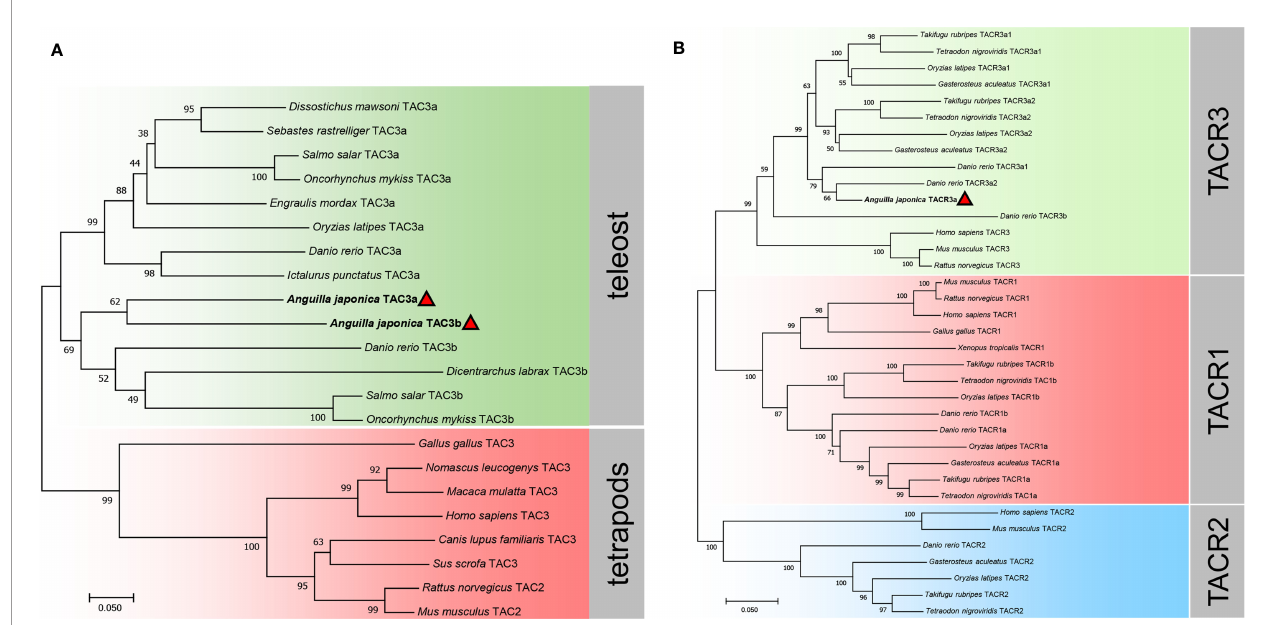
FIGURE 3 | Phylogenetic analysis of the tac3 (A) and tacr (B) gene family in vertebrates. The phylogenetic trees were constructed by MEGA 7 using the neighbor-joining method. Data were resampled with 1,000 bootstrap replicates. The accession numbers of each sequence are Dissostichus mawsoni tac3a (DAA35156.1), Sebastes rastrelliger tac3a (XP_037630002.1), Salmo salar tac3a (XP_013991334.1), Oncorhynchus mykiss tac3a (XP_021421533.1), Engraulis mordax tac3a (DAA35163.1), Oryzias latipes tac3a (NP_001265832.1), Danio rerio tac3a (NP_001243318.1), Ictalurus punctatus tac3a (XP_017343311.1), Danio rerio tac3b (NP_001243319.1), Dicentrarchus labrax tac3b (QYB17058.1), Salmo salar tac3b (XP_014022643.1), Oncorhynchus mykiss tac3b (CDQ91399.1), Gallus gallus tac3 (XP_015155892.2), Nomascus leucogenys tac3 (XP_003252831.1), Macaca mulatta tac3 (XP_001115535.2), Homo sapiens tac3 (AAQ10783.1), Canis lupus familiaris tac3 (NP_001279988.1), Sus scrofa tac3 (NP_001007197.1), Rattus norvegicus tac2 (NP_062035.1), Mus musculus tac2 (BAA03316.1), Takifugu rubripes tacr3a1 (NP_001267026.1), Tetraodon nigroviridis tacr3a1 (DAA35148.1), Oryzias latipes tacr3a1 (NP_001265839.1), Gasterosteus aculeatus tacr3a1 (XP_040043470.1), Takifugu rubripes tacr3a2 (NP_001267041.1), Tetraodon nigroviridis tacr3a2 (DAA35149.1), Oryzias latipes tacr3a2 (NP_001265803.1), Gasterosteus aculeatus tacr3a2 (XP_040042202.1), Danio rerio tacr3a1 (NP_001243567.1), Danio rerio tacr3a2 (NP_001243564.1), Danio rerio tacr3b (XP_002666594.1), Homo sapiens tacr3 (NP_001050.1), Mus musculus tacr3 (AAH66845.1), Rattus norvegicus tacr3 (NP_058749.1), Mus musculus tacr1 (NP_033339.2), Rattus norvegicus tacr1 (NP_036799.1), Homo sapiens tacr1 (NP_001049.1), Gallus gallus tacr1 (NP_990199.1), Xenopus tropicalis tacr1 (NP_001106489.1), Takifugu rubripes tacr1b (XP_029693280.1), Tetraodon nigroviridis tacr1b (CAG05392.1), Oryzias latipes tacr1b (XP_011479687.1), Danio rerio tacr1b (NP_001268728.1), Danio rerio tacr1a (NP_001257407.1), Oryzias latipes tacr1a (NP_001265826.1), Gasterosteus aculeatus tacr1a (XP_040052094.1), Takifugu rubripes tacr1a (NP_001267036.1), Tetraodon nigroviridis tacr1a (CAG12579.1), Homo sapiens tacr2 (NP_001048.2), Mus musculus tacr2 (NP_033340.3), Danio rerio tacr2 (NP_001314788.1), Gasterosteus aculeatus tacr2 (XP_040059362.1), Oryzias latipes tacr2 (XP_011489426.1), Takifugu rubripes tacr2 (NP_001267009.1), and Tetraodon nigroviridis tacr2